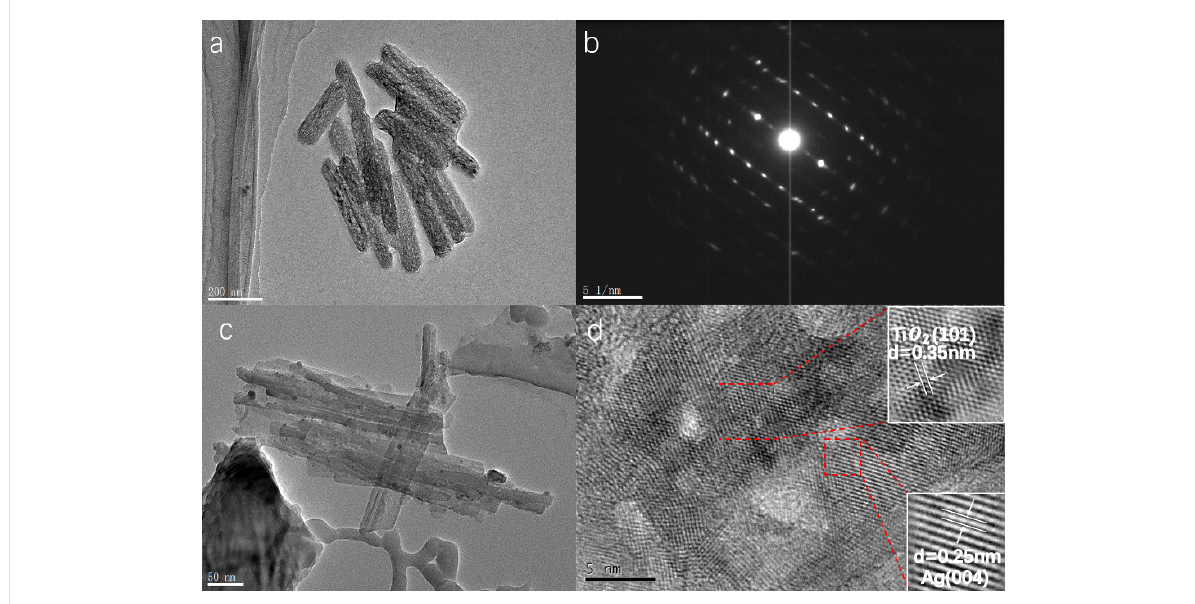
Figure 4: TEM images of nanocolumn structures. a) TNC nanocolumn TEM image, b) TNC TEM diffraction pattern, c) AFT1 TEM image, d) AFT1 nanocolumn high-resolution TEM image, where the insets show the image processed by the software in the selected areas of the red-dotted line frames.